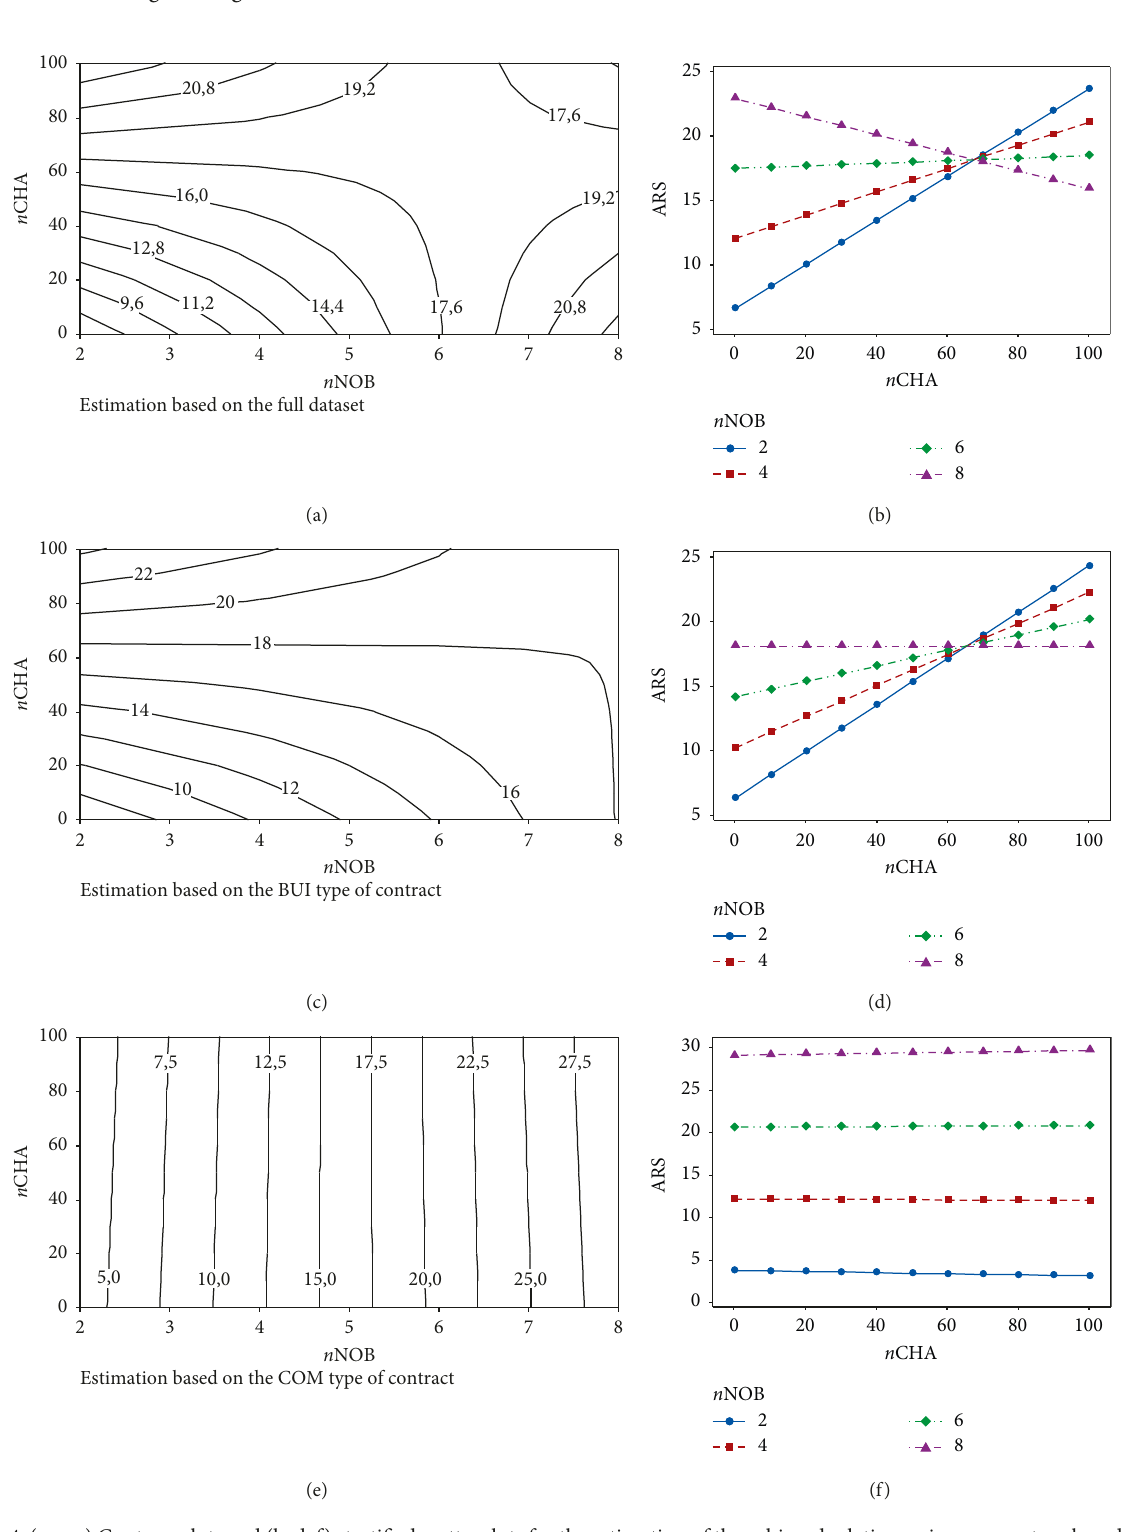
Figure 4: (a, c, e) Contour plots and (b, d, f) stratified scatterplots for the estimation of the achieved relative savings percentage based on the number of bidders, the number of changes, and its interaction, for the full construction e-RA auctions dataset and the BUI and COM types of contract